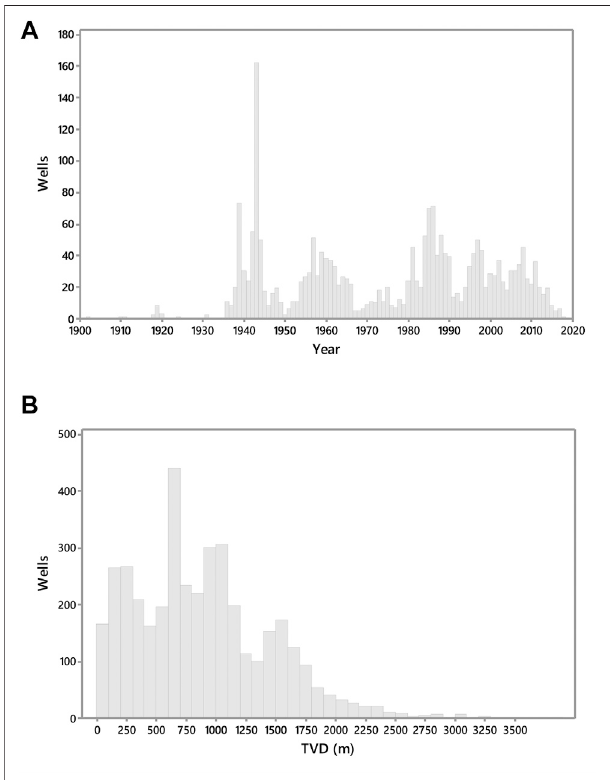
FIGURE 2 | Histograms of boreholes drilled onshore the United Kingdom from the UKOGL database a) by year and b) TD TVD.